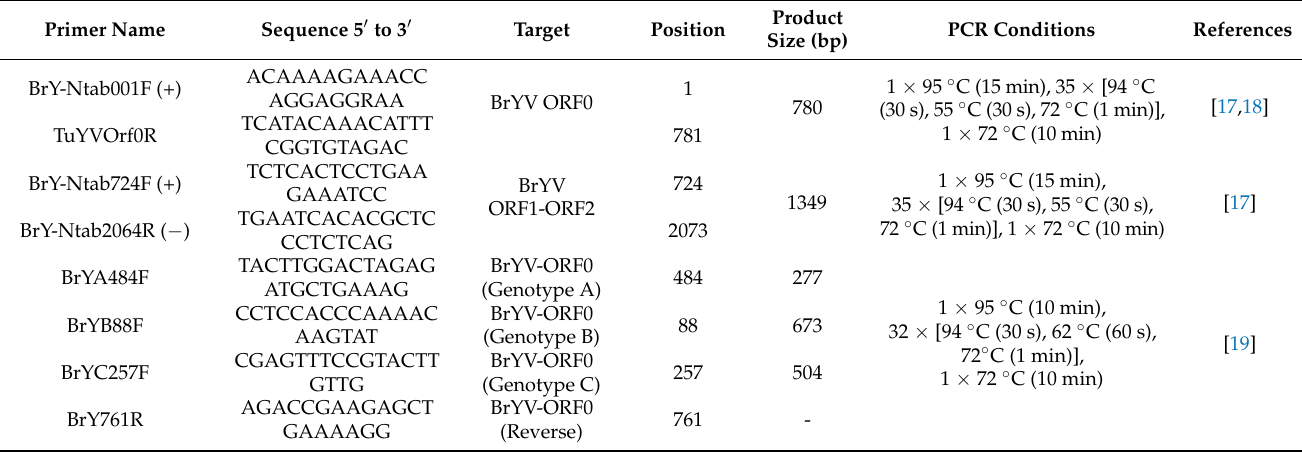
Table 1. Primers used for RT-PCR, multiplex RT-PCR, and